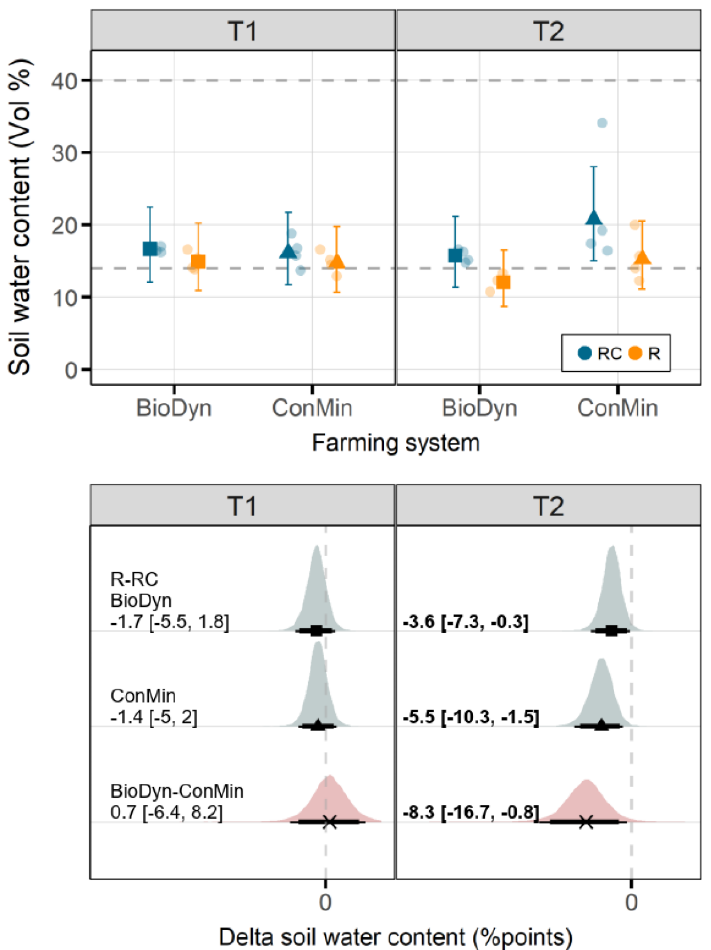
Figure 4. Upper panel: Volumetric soil water content (Vol%) (top 10 cm of soil), dashed lines: estimated wilting point (bottom line) and field capacity (top line) and semi-transparent points: raw data and lower panel: differences in the soil water content in response to drought treatments (R-RC in BioDyn: rectangle and R-RC in ConMin: triangle), along with differences between the farming systems (BioDyn-ConMin: cross; effects were calculated as averages over the drought treatments). All data are medians of the posterior distribution with 95% credible intervals (CrIs), factor system: biodynamic farming system (BioDyn) and conventional farming system (ConMin), factor drought: rainout shelter control (RC) and rainout shelter (R) and factor sampling: first sampling (T1) and second sampling (T2). Credible intervals in bold exclude zero.